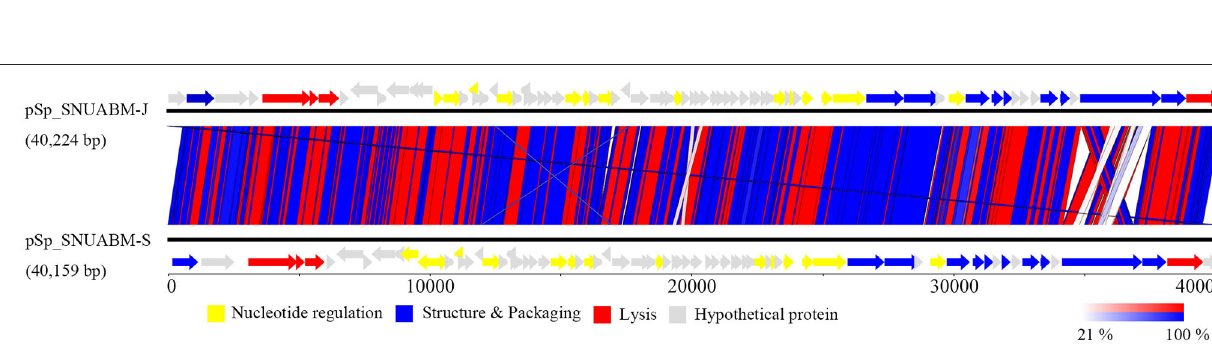
FIGURE 6 | The endpoint reaction measurement for biofilm degradation by pSp-J, pSp-S, and the phage cocktail. (A) The total biomass of biofilm was stained with crystal violet and the optical density (OD) at 595nm was measured. (B) The viable bacterial cell count in the biofilm was measured by the standard plate count and (C) visualized with a confocal laser scanning microscope. Scale bar = 100 µ m. Values are presented as the mean ± standard deviation, and a one-way ANOVA (Bonferroni post-hoc test) was performed to determine statistically significant differences ( P < 0.05) between groups. Asterisk indicates statistical significance between the experimental and control group.